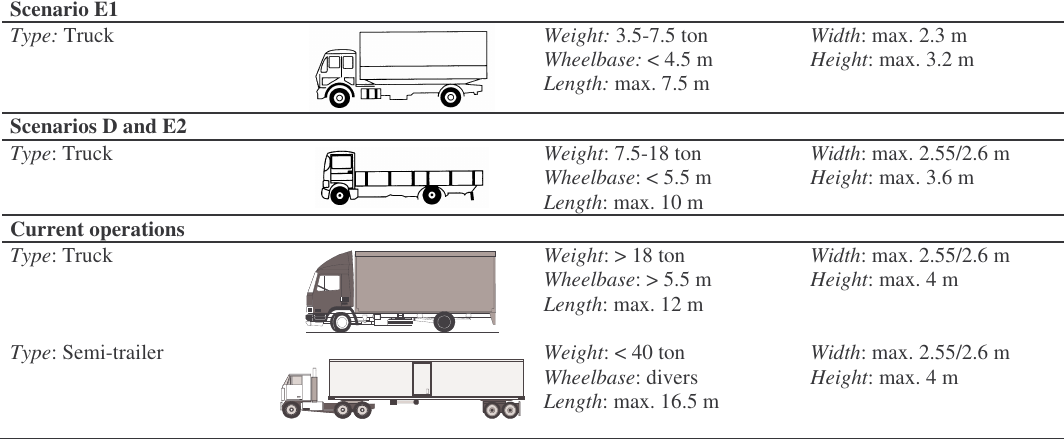
Table 4. Vehicle types used in